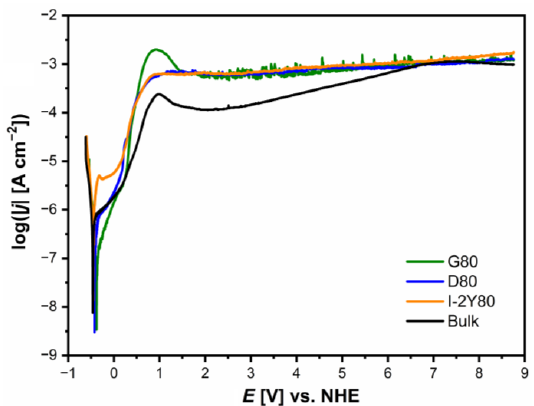
Figure 11. Anodic polarization curves for the CpTi G2 cellular lattice with TPMS architecture of G80, D80, I-2Y80, and the bulk electrode in 0.1 M KOH solution saturated with O 2 at 25